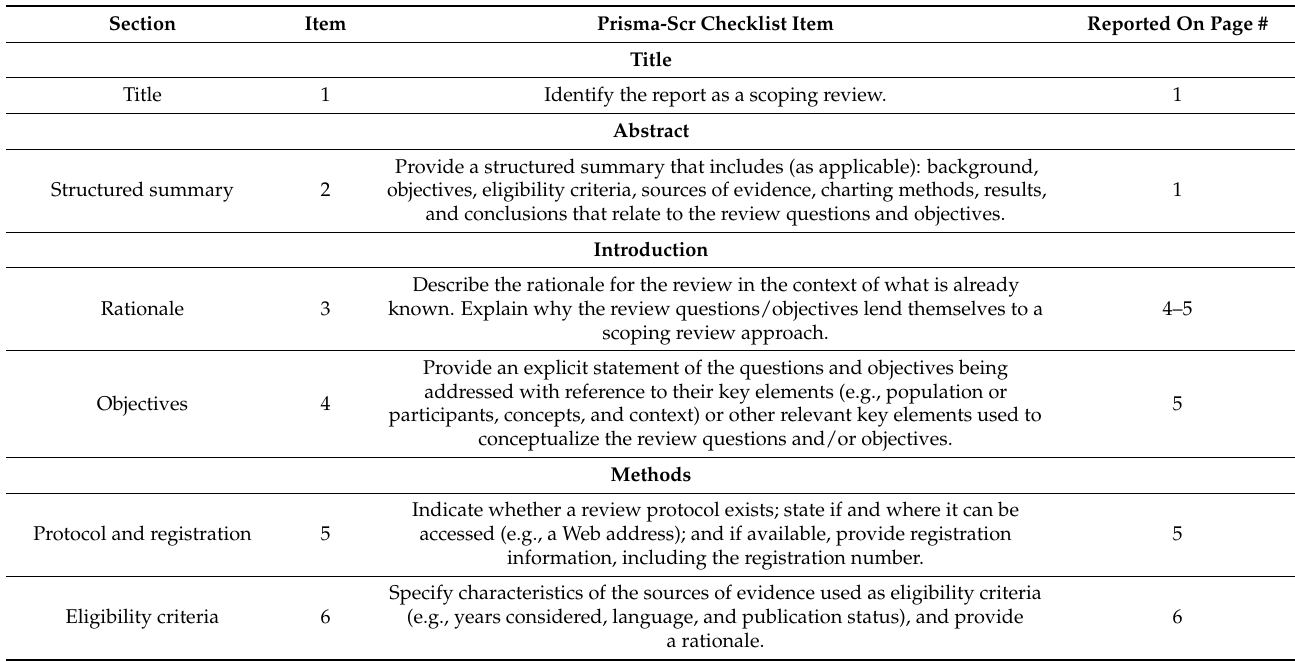
Table A1. Preferred Reporting Items for Systematic Reviews and Meta-Analyses Extension for Scoping Reviews (PRISMA- ScR)